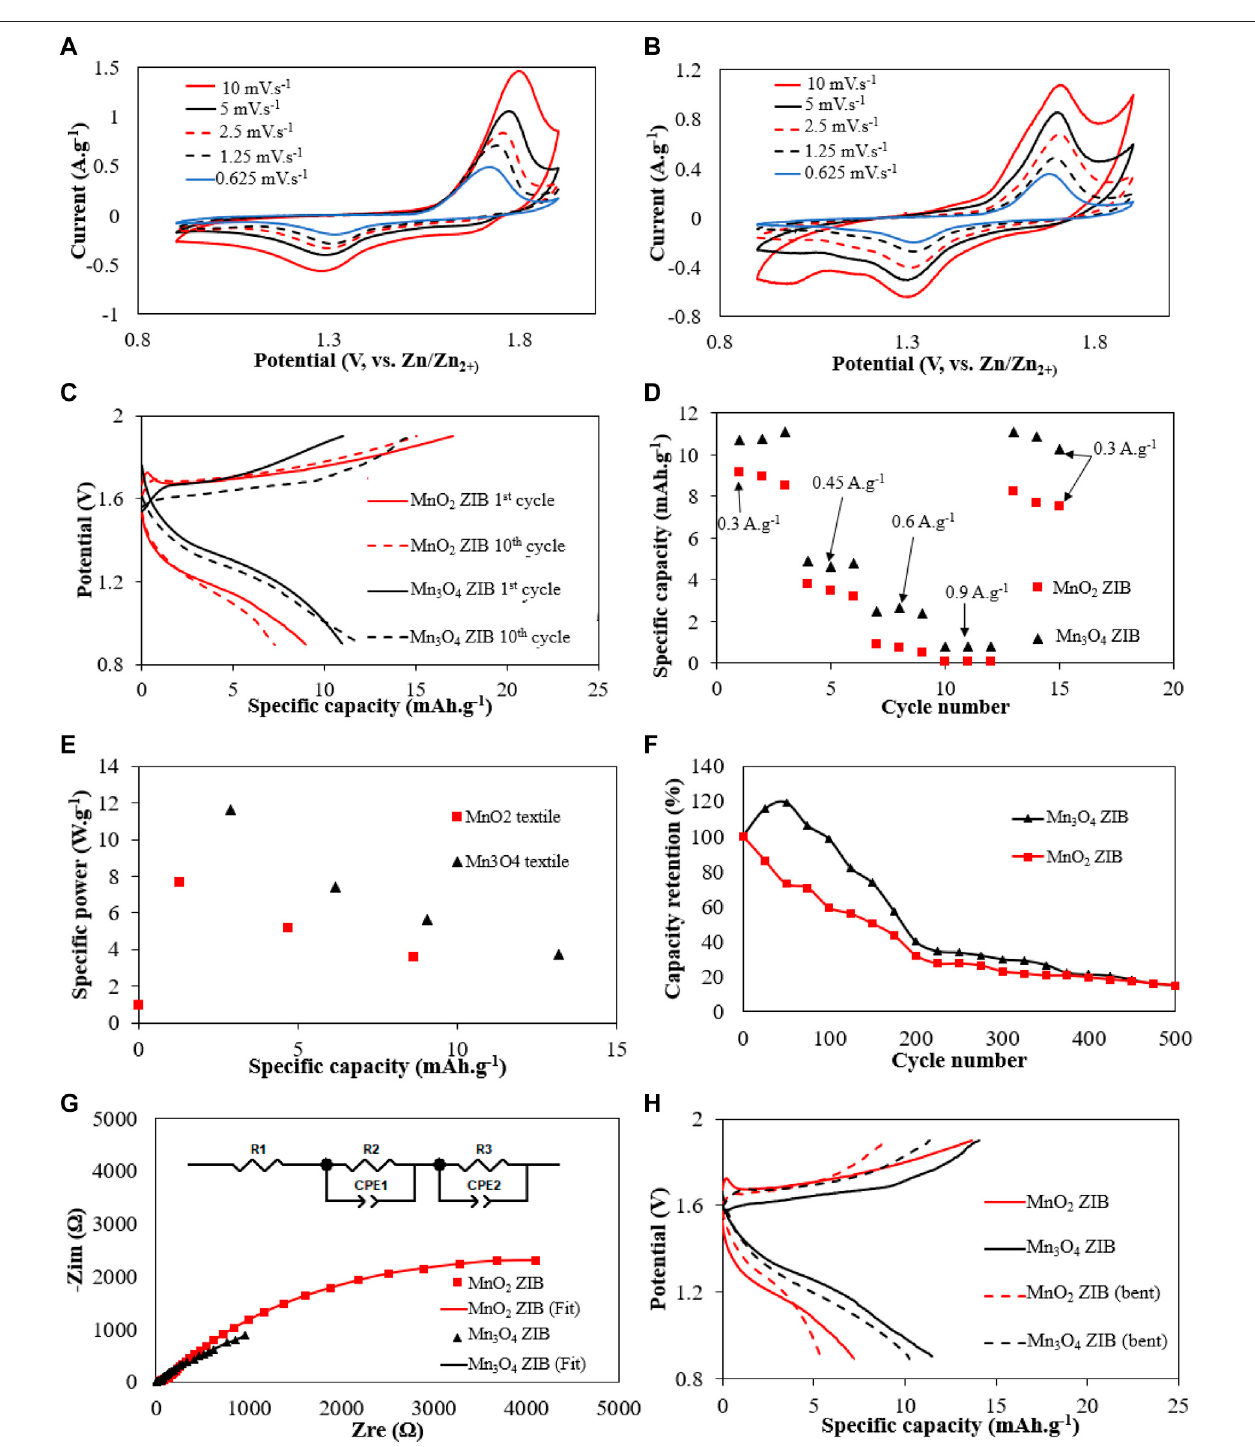
FIGURE 5 | Electrochemical performance of textile ZIB cells with MnO 2 and Mn 3 O 4 cathode (A) CV of textile ZIB cells with the Mn 3 O 4 cathode at scan rates between 10 and 0.625 mV s − 1 . (B) CV of textile ZIB cells with MnO 2 cathode at scan rates between 10 and 0.625 mV s − 1 . (C) the charging/discharging test. (D) Rate capabilities. (E) Ragone plot from 1 to 3 mA cm − 2 (0.3 – 0.9 A g − 1 ). (F) cycling performance of the two ZIBs up to 200 cycles. (G) Nyquist plots between 1 and 1 M Hz afterchargingto+1.9 V. (H) ThechargeanddischargeresultsoftextileZIBcellswithMnO 2 andMn 3 O 4 cathodebeforeandafterbendingexperiment(2000cycles).